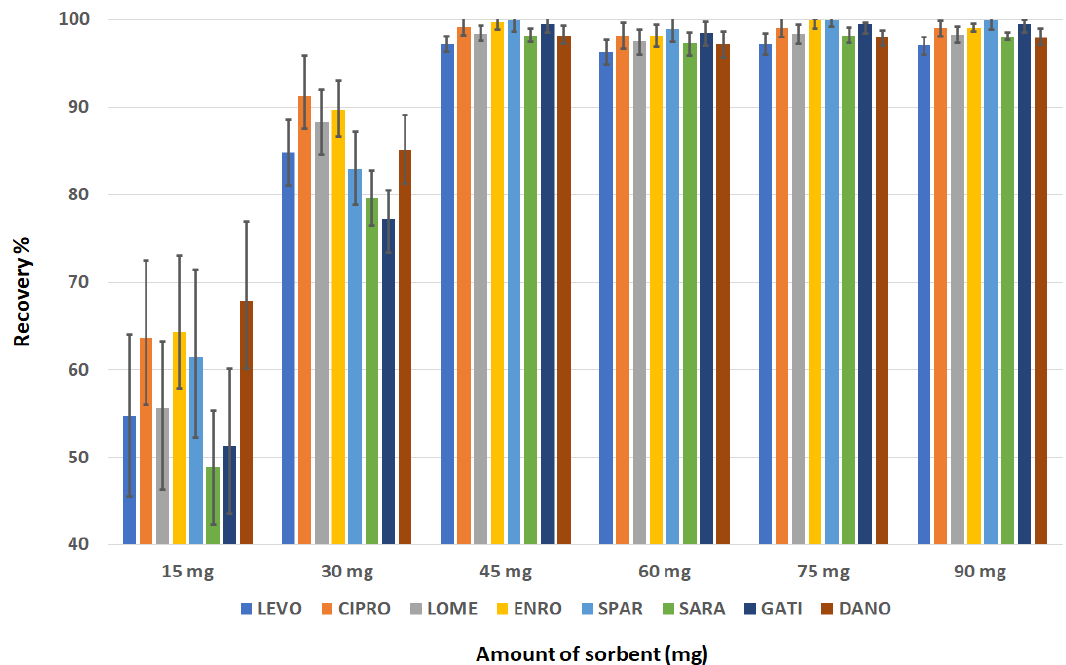
Figure 10. Effect of sorbent amount on the recovery.